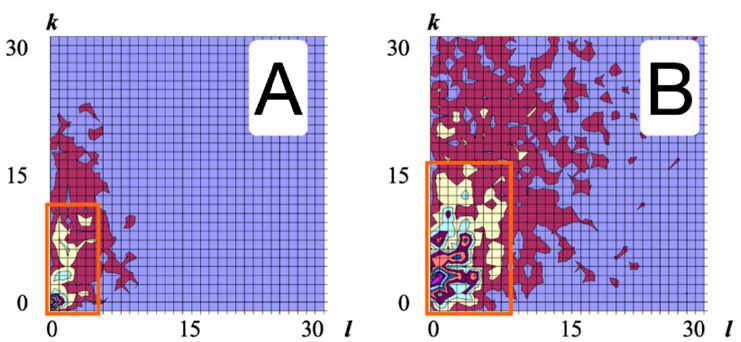
Figure 12. The SEM images’ morphological spectra of the initial—( A ) and the modified—( B ) samples; k, l—the biharmonic indexes. The orange rectangles show the localization zones of the spec- tra.